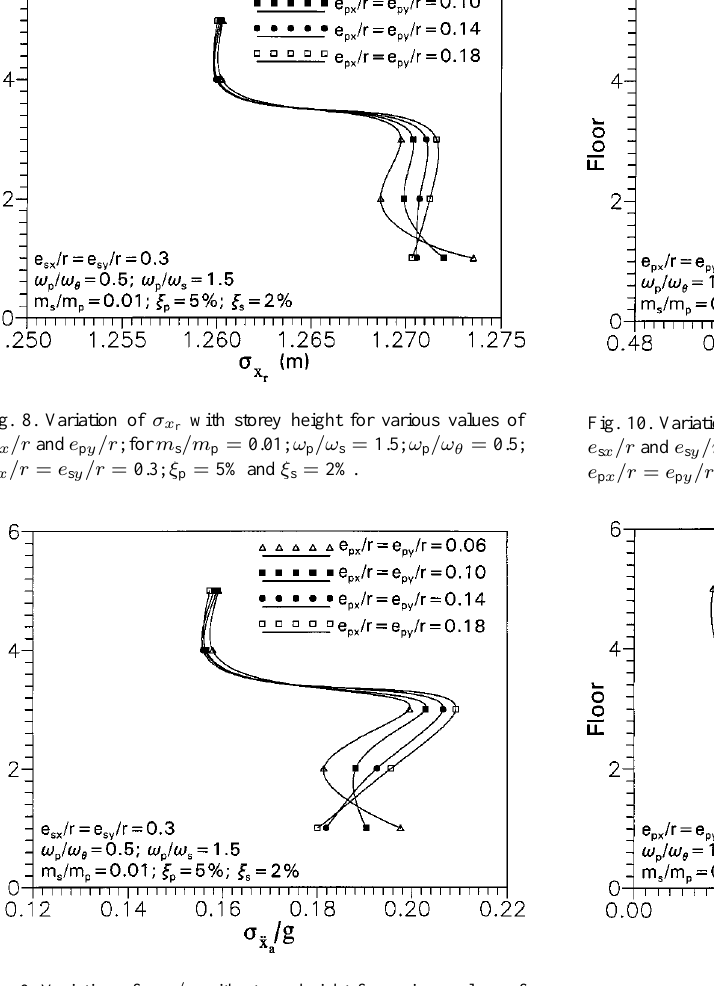
=g with storey height for various values of Fig. 11. Variation of (cid:27) (cid:127) x a e s x =r and e s y =r ; for m s =m p = 0.01; ! p =! s = 1.0; ! p =! (cid:18) = 1.0; e p x =r = e p y =r = 0.1; (cid:24) p = 5% and (cid:24) s =